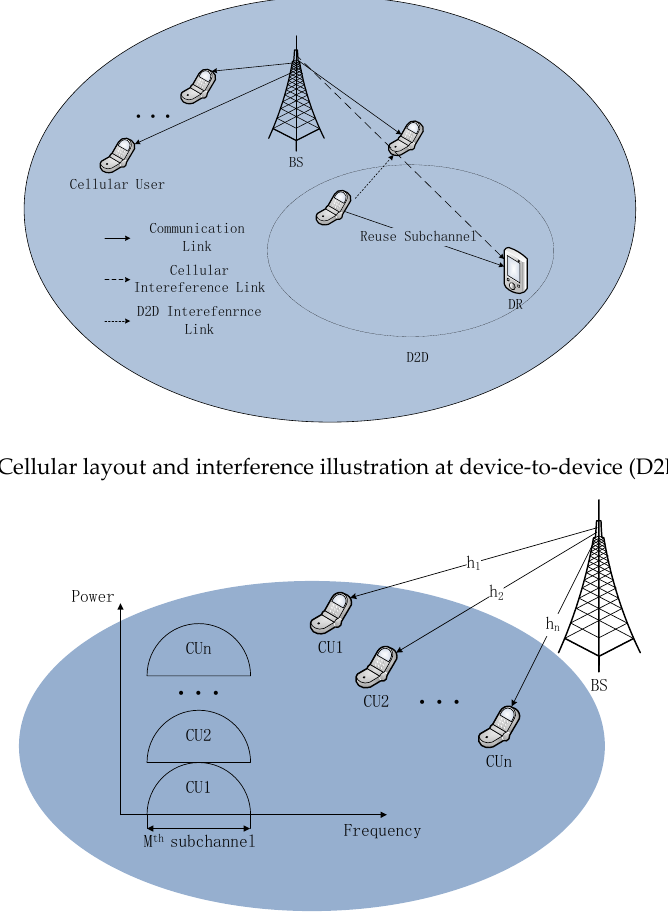
Figure 1. Illustration of the NOMA-based cellular network with D2D. ( a ) Interference of cellular and D2D users. ( b ) Power versus frequency on each subchannel.